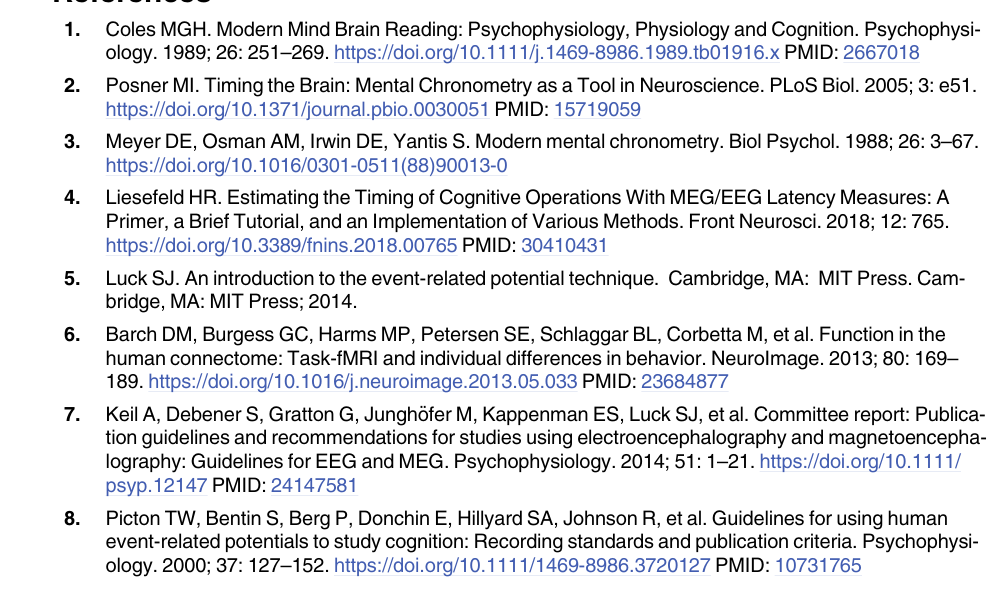
Gaussian process regression model, upsampled to 1 MHz (Peak Fitted) are presented. Data are presented for all ERP components of interest and for 1/2, 1/3, 1/4, and 1/5 splits of the alter- nate-draw data set. S2 Table. Internal consistency (Cronbachs Alpha), data quality (Standardized Measure- ment Error = SME), and the effects of data pruning for the 1/5 data split for all measures retrieved and all ERP components of